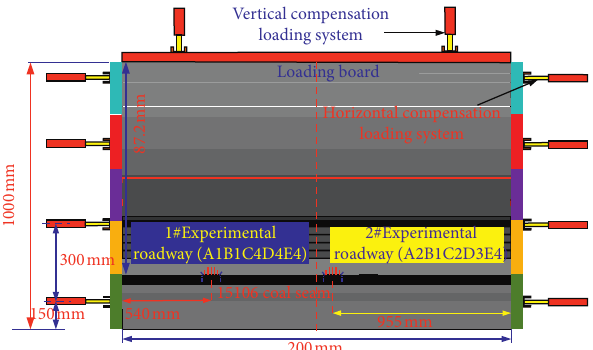
Figure 8: Similar experimental model design and experimental roadway layout.